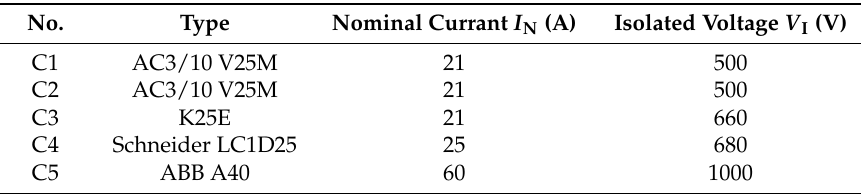
Table 4. List of tested